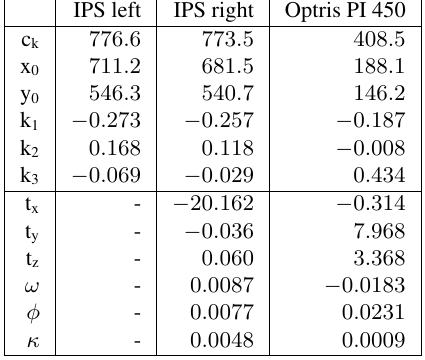
Table 3. Calibration Results for the trifocal sensor (intrinsic calibration is given in px and extrinsic calibration is given in cm or in rad ) Concerning the accuracy, with 30 image triplets, the intrinsic and extrinsic calibration parameters were estimated precisely enough to perform sub-pixel matching between the sensor image data. The accuracy of the calibration model is measured by the stan- dard deviation of the residuals (RMS). For a set with 30 image triplets and roughly 18 000 corner points, the RMS seems to be stabilized at 0 . 293px . Another visual interpretation for the ac- curacy of the calibration model is the epipolar geometry, which is a prerequisite for subsequent matching tasks. From fig. 5(b) it can be seen that the epipolar error is in the sub-pixel range. Furthermore the standard deviation of the focal length (for the LWIR sensor) of 0 . 8px is slightly better than Vidas et al. (2012) approach with masked backdrops and far better than their test re- sults with heated chessboards (standard deviation of 14px